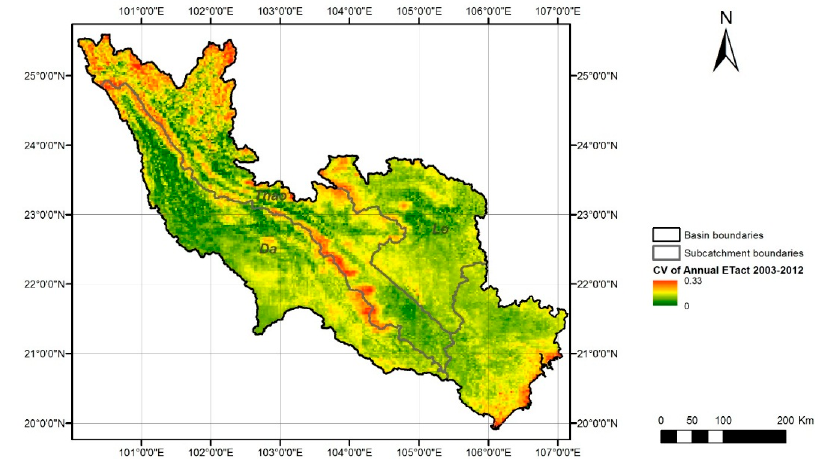
Figure A4. Map of the coefficient of variation (CV) of annual average ET act based on five different products.